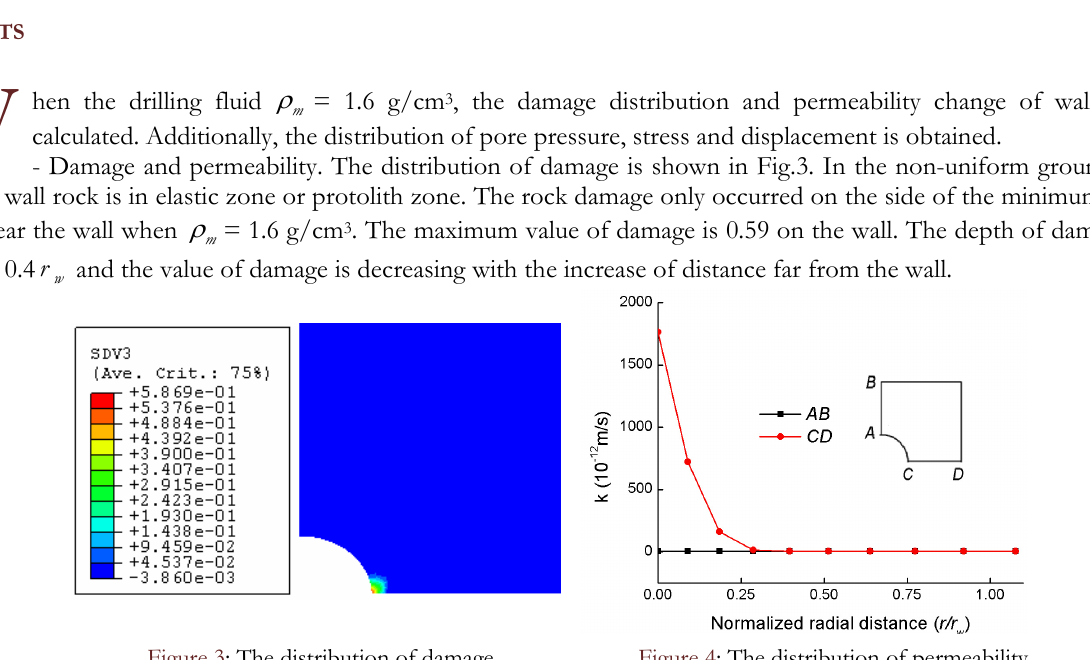
Figure 3: The distribution of damage. Figure 4: The distribution of